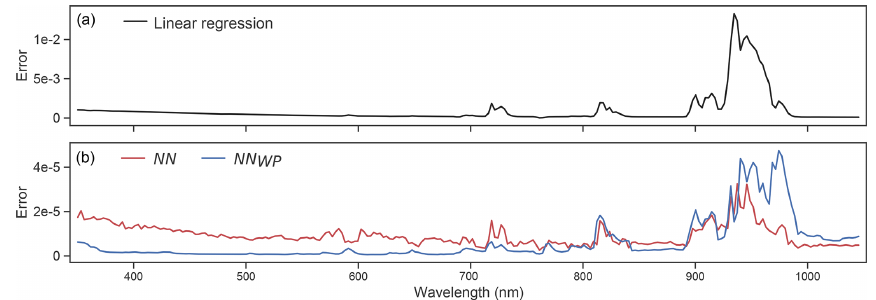
Figure 3. (a) ρ obs test prediction error per channel using channelwise linear regressors (black line). (b) Neural network test prediction error per channel using subnetworks trained from scratch (NN, red line) versus subnetworks trained with weight propagation (NN WP , blue line).